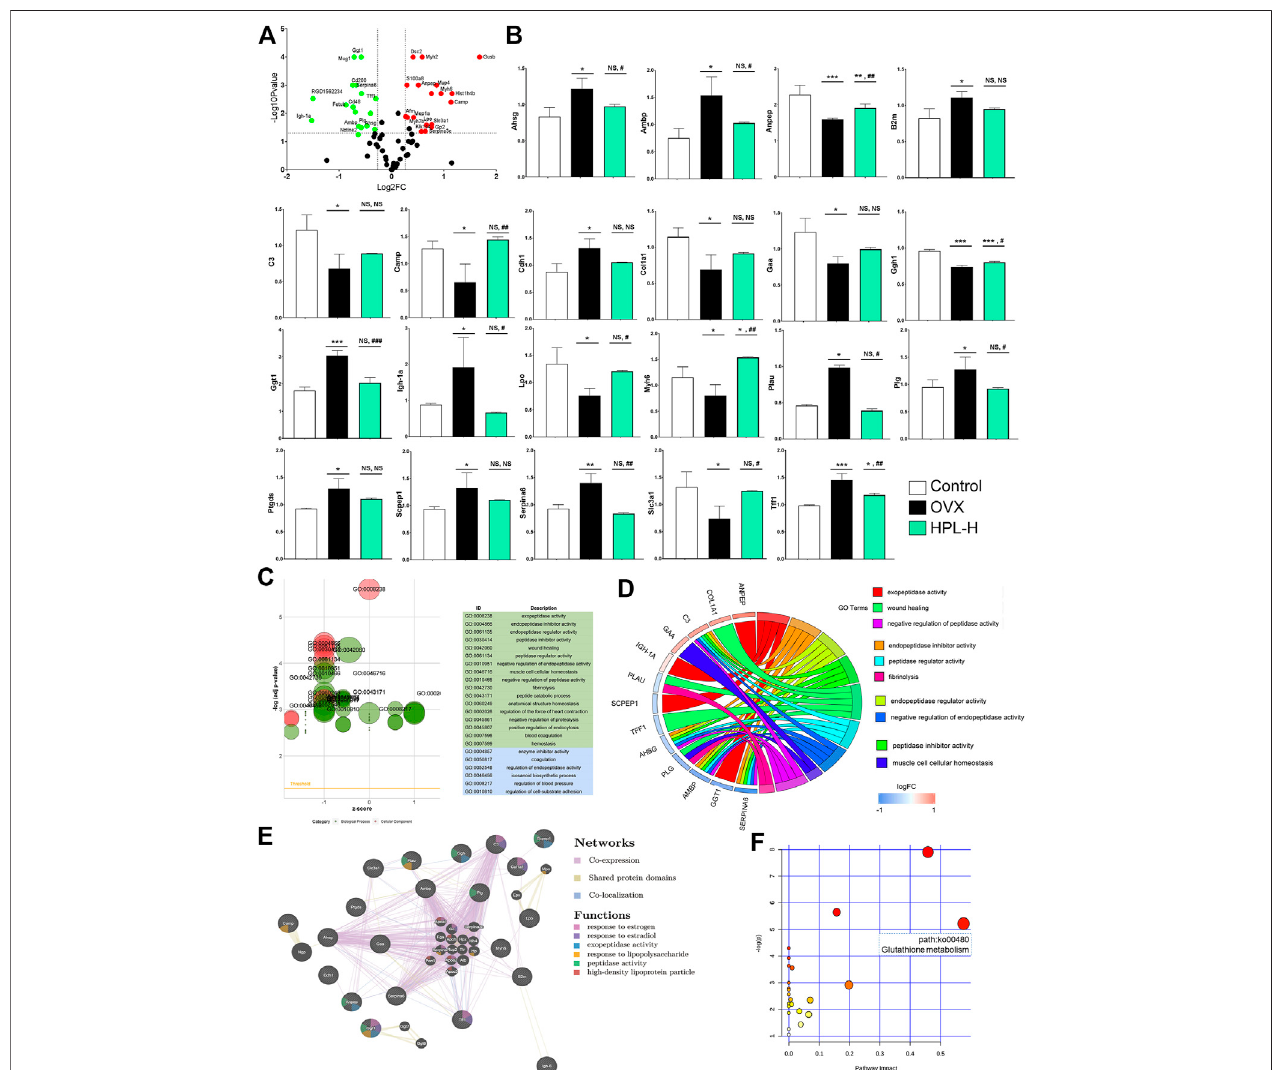
FIGURE 2 | HPL therapy rescues the overall renal proteomic dysfunction induced by OVX. (A) Volcano plot of differentially expressed proteins identi fi ed in rats treatedwithHPL(HPL-H,300 mg/kg/d).The X -axisshowsthe117/116ratioofproteins,re fl ectingtheratioofexpressionlevelsinHPL-treatedratstoOVXrats,whilethe Y axis represents the p value of the repetition test, and each point in the plot represents one protein ratio. Red represents upregulated proteins, and green represents downregulatedproteins. (B) Levelsofthe21screenedproteinsafterHPLtreatment. (C) GObubbleplotillustratingthesigni fi cantenrichmentofmolecularfunctions and biological processes (adjusted p -value < 0.05) and the z -score of the term. The X -axis shows z -scores, and the Y -axis shows adjusted p values. Different colors representthreemajorcategories:greenindicatesbiologicalprocesses(BPs)andblueindicatesmolecularfunctions(MFs).EachbubblerepresentsoneGOterm,andthe bubble size represents the number of regulated genes. (D) GO Chord plot illustrating the gene annotation enrichment relationships and representative signi fi cant GO terms that are distinctly classi fi ed into species-speci fi c gene clusters. The left side shows strongly enriched genes, and the blue-to-red boxes of the selected genes indicate the logFC values. The right side shows the enriched GO terms (E) Protein – protein interaction network identi fi ed using GeneMANIA (direct interaction database) (F) Gene-centred KEGG pathway enrichmentplotofthe screened proteins. Thebubblesizeand color(varying fromyellowtored)representthe signi fi cance levels ofthe pathway.* p < 0.05,** p < 0.005,and*** p < 0.0005comparedwithcontrolrats;# p < 0.05,## p < 0.005,and### p < 0.0005comparedwithOVXrats.NS,notsigni fi